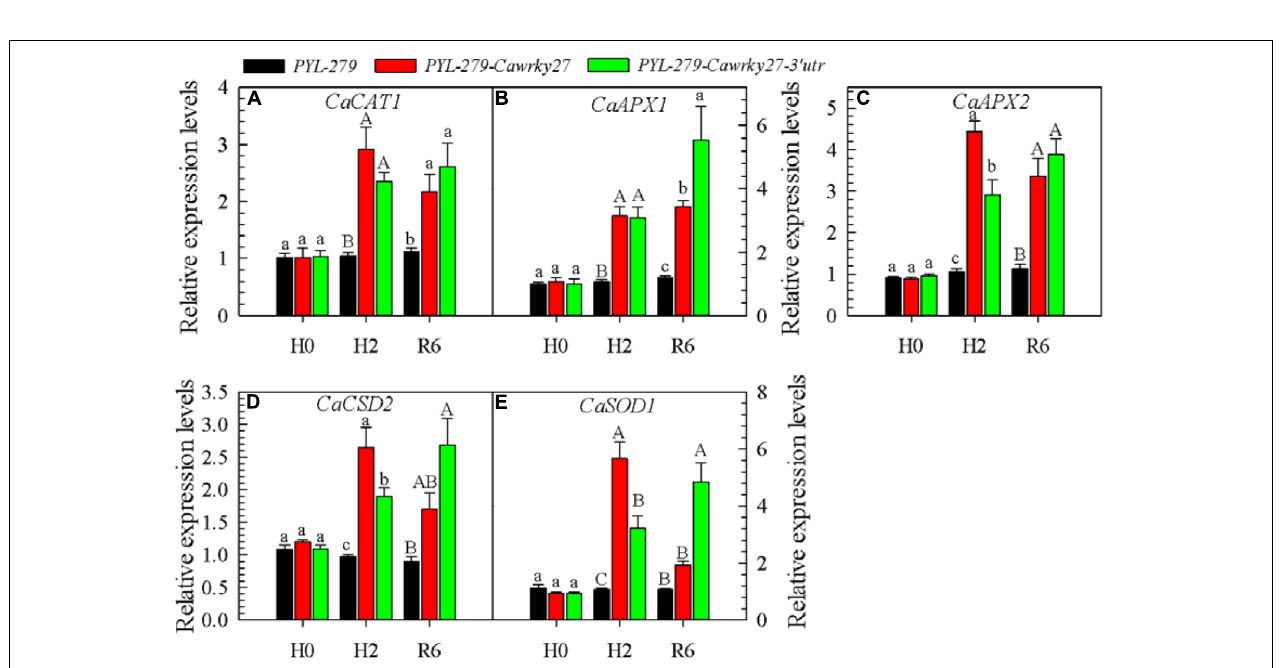
FIGURE 8 | Analysis of defense-associated gene expression in CaWRKY2 7-silenced plants. The silenced ( PYL-279-wrky27 and PYL-279-wrky27-3’utr ) and control ( PYL-279 ) pepper plant leaves were harvested after 0 and 2 h at 37 ◦ C, and after 6 h of recovery at 25 ◦ C (after 2 h of heat treatment). (A–E) Relative transcript levels of genes encoding the ROS-scavenging enzymes CaCAT1 , (A) ; CaAPX1 , (B) ; CaAPX2 , (C) ; CaCSD2 , (D) ; and CaSOD1 , (E) . The transcript level of each gene was determined by qRT-PCR and normalized against CaActin , followed by normalization against the transcript level of the gene in PYL-279. Data represent the mean ± SE of three biological replicates. Different letters indicate significant differences compared to the control ( SNK- test, lowercase letters indicate P < 0.05 and uppercase letters indicate P < 0.01).